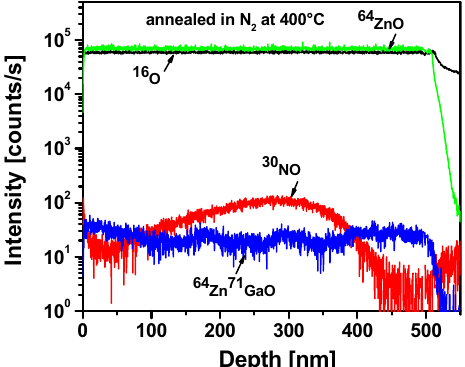
Fig. 5. SIMS depth profiles of N-implanted ZnO:Ga films an- nealed in N 2 at 400 ◦ C for 10 s.